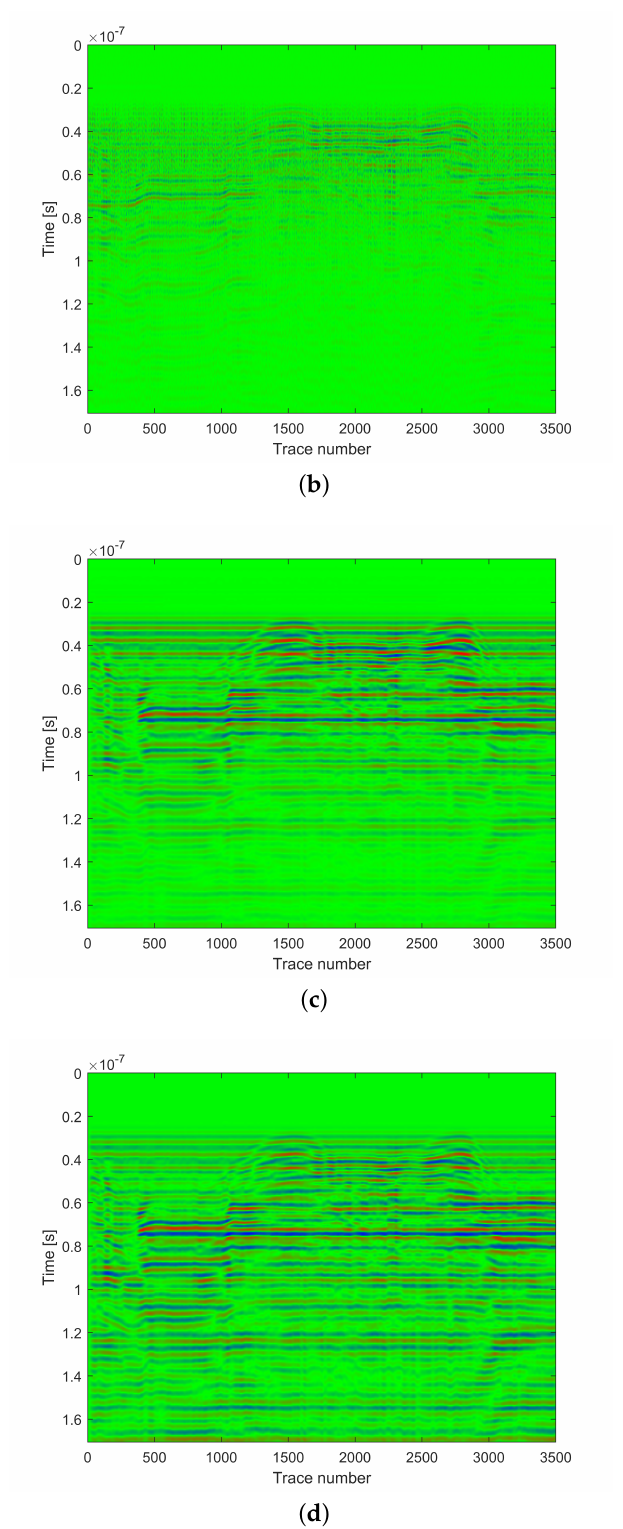
Figure 17. The results of each step corresponding to Figure 7. ( a ) CCBS clutter subtraction. ( b ) Electromagnetic interference removal. ( c ) Rotor interference suppression. ( d ) Gain process- ing. With the increase of processing steps, the clutter and some interference are gradually removed, and then the location of underground target is more and more